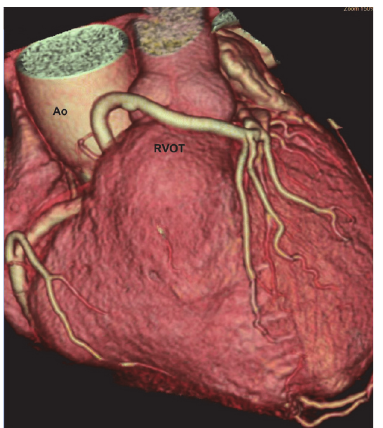
Figure 5: VR image showing ectopic LMCA with a prepulmonic course over the right ventricular outflow tract giving rise to LAD (Ao: aorta; RVOT: right ventricular outflow tract).